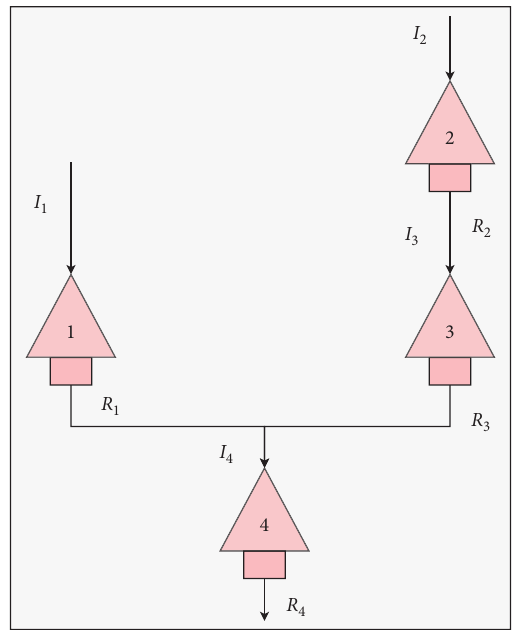
Figure 2: Four reservoir systems. 1, 2, 3, and 4: number of res- ervoirs; I1 , I2 , I3 , and I4 : inflows to reservoirs 1, 2, 3, and 4, re- spectively; R1 , R2 , R3 , and R4 : releases from reservoirs 1, 2, 3, and 4, respectively. Table 1: Data for the DFRO system (benchmark problem)